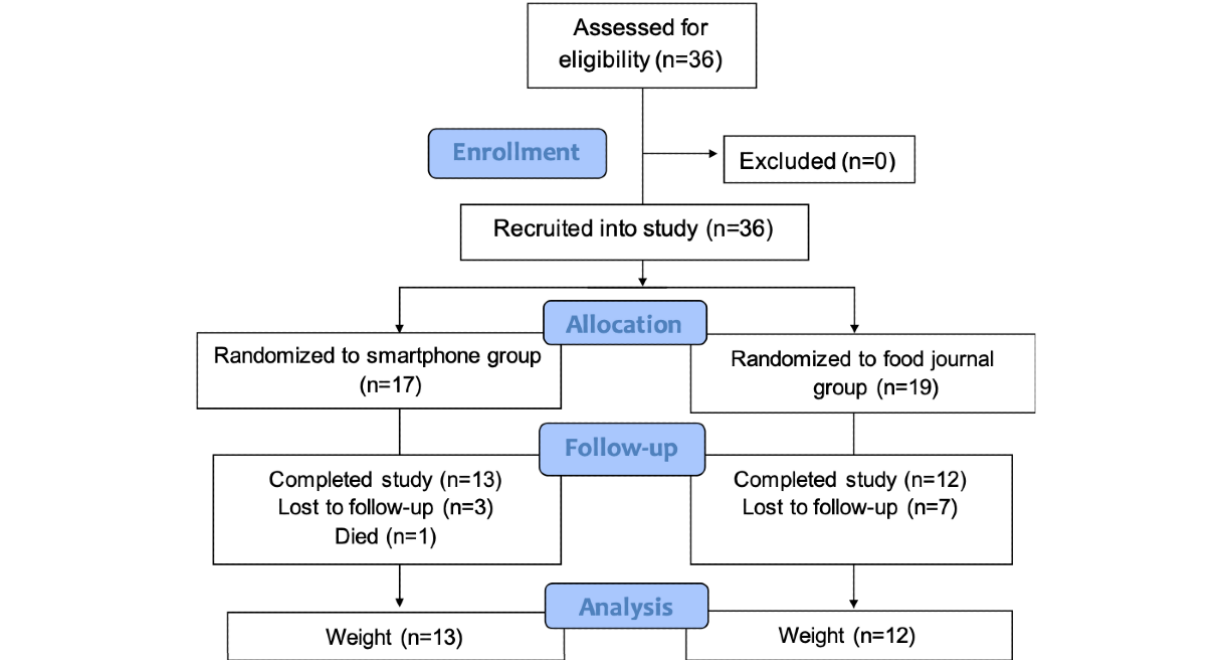
Figure 2. Swipe out Stroke Consolidated Standards of Reporting Trials (CONSORT) flow